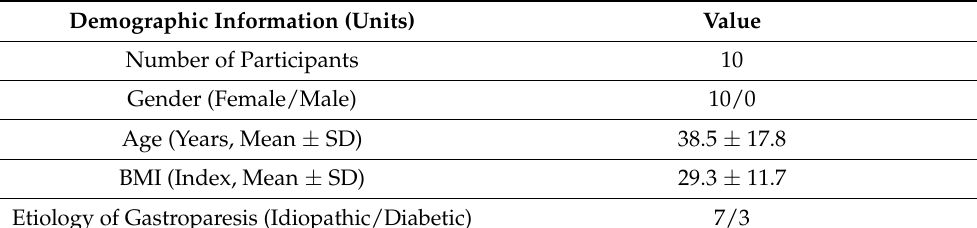
Table 1. General summary of study